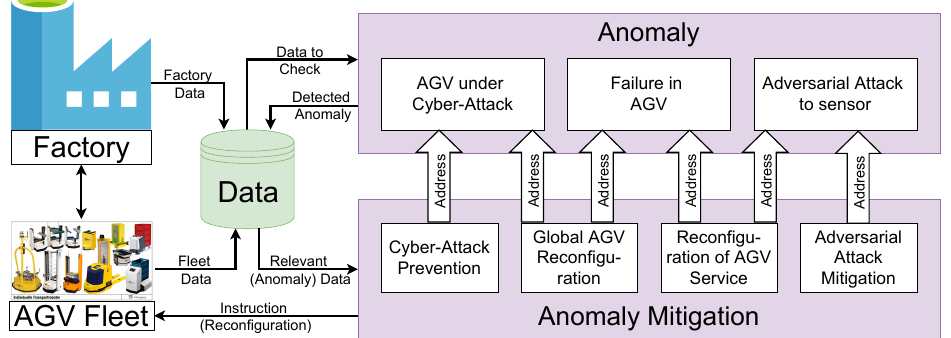
Figure 6. Overview for detection and mitigation of different